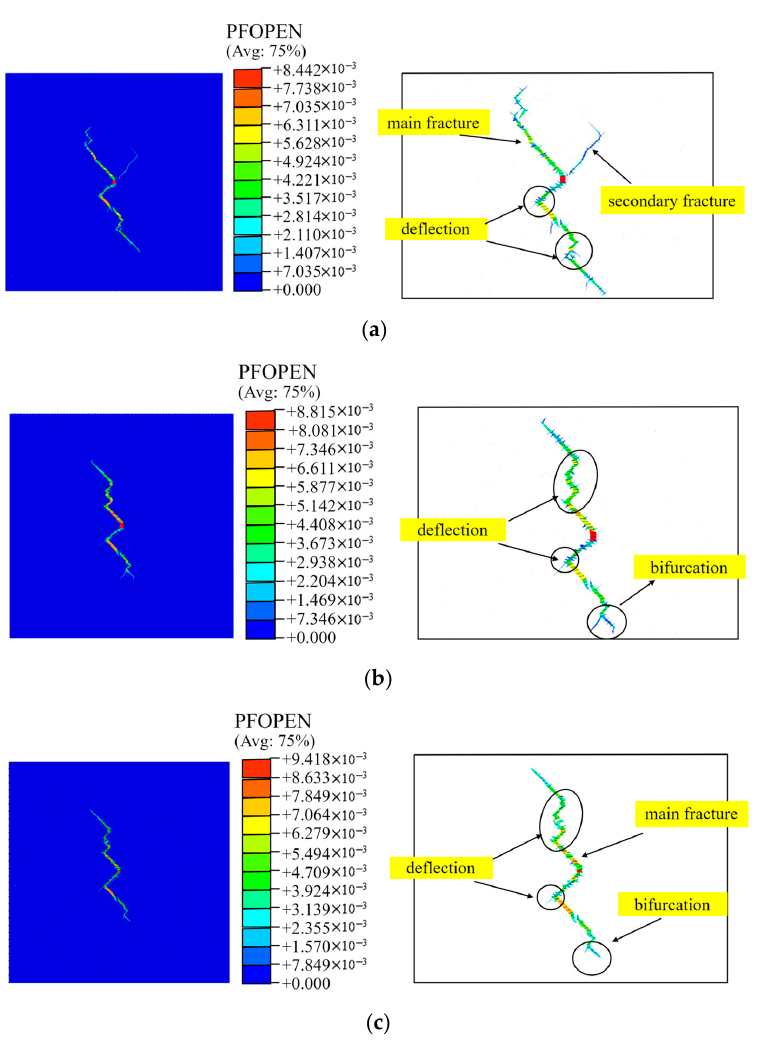
Figure 13. The extracted morphology of hydraulic fractures under different rock tensile strengths.